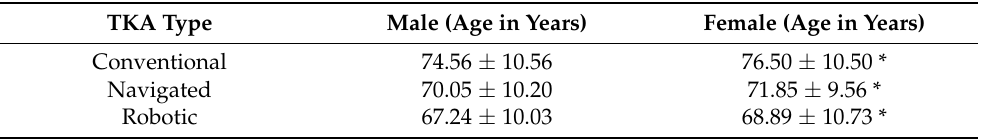
Table 2. Tabular chart from the mean age of patients who had a TKA between 2010 and 2021 in Germany divided by gender and the TKA surgical technique. Values are given as mean ± standard deviation. Two-way ANOVA; * p < 0.0001 vs.